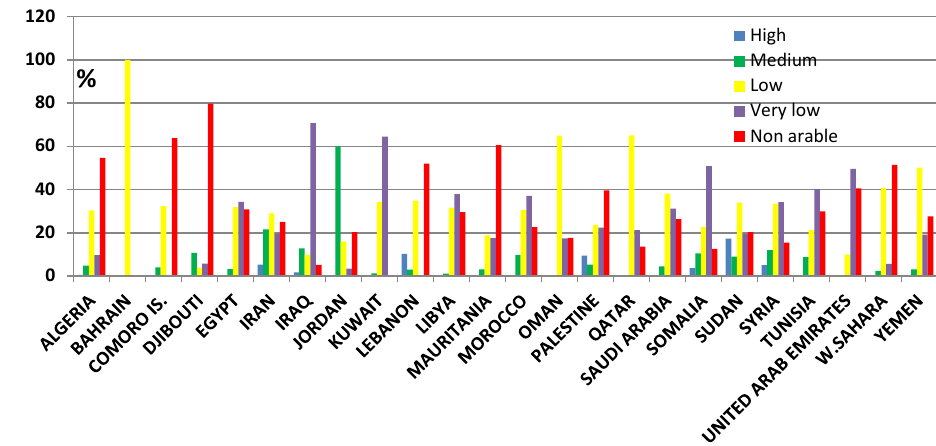
Figure 2. Distribution of land capability classes (% of total national area) for 20 countries and territories of the NENA region, based on the USDA model (1999) and Digital Soil Map of the World (FAO,